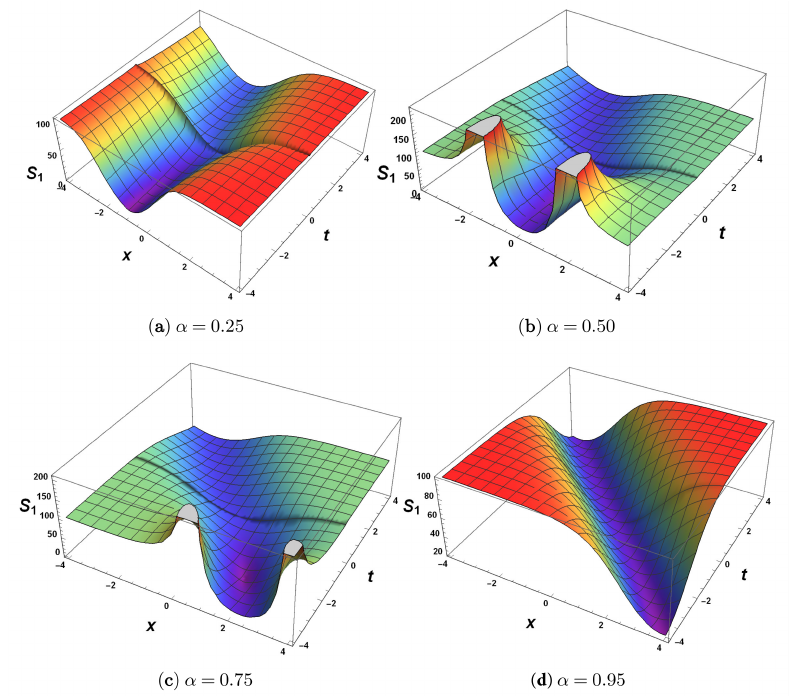
Figure 3. A 3D graphical representation for S 1 .